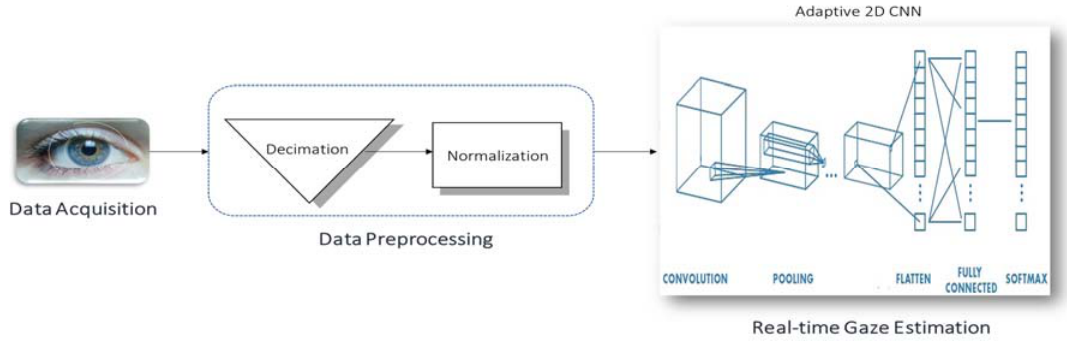
Figure 8. Block diagram of convolutional neural network (CNN).